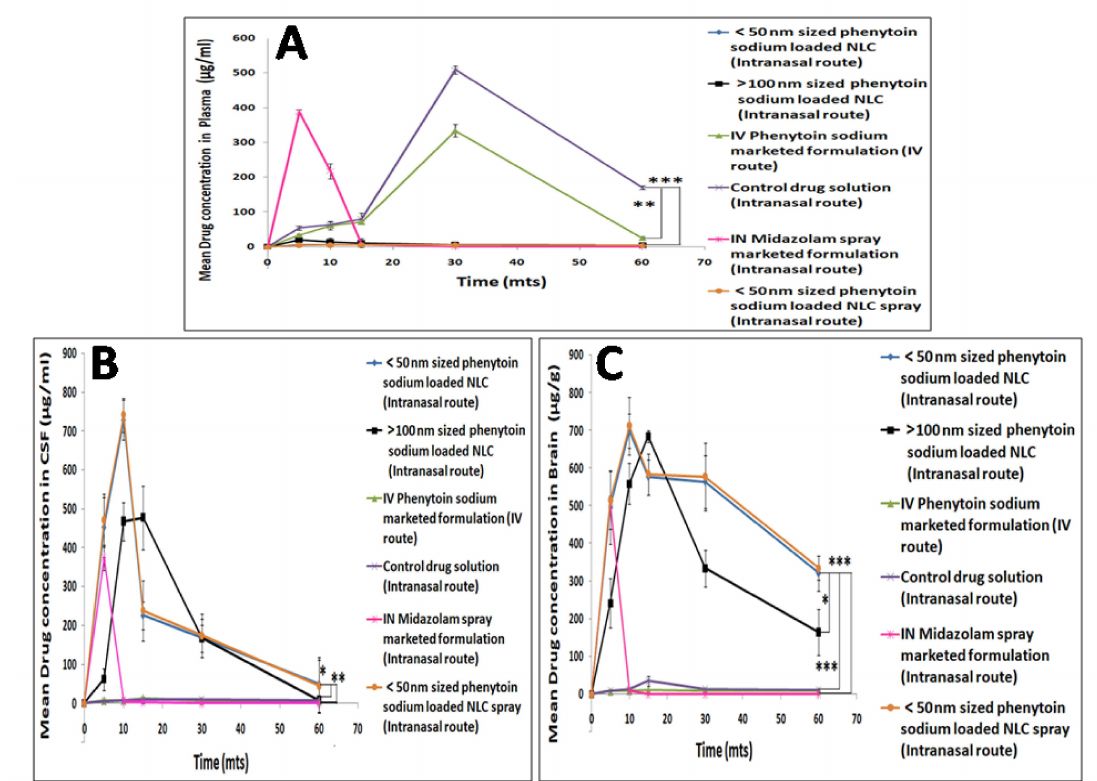
Figure 7. Mean plasma ( A ), CSF ( B ) and brain ( C ) drug concentration profile following intranasal administration of phenytoin sodium NLCs, control drug solution, midazolam marketed formulation and IV administration of phenytoin sodium marketed formulation. The level of statistical significance is expressed as a p -value; * indicates p < 0.05, ** indicates p < 0.01, *** indicates p <